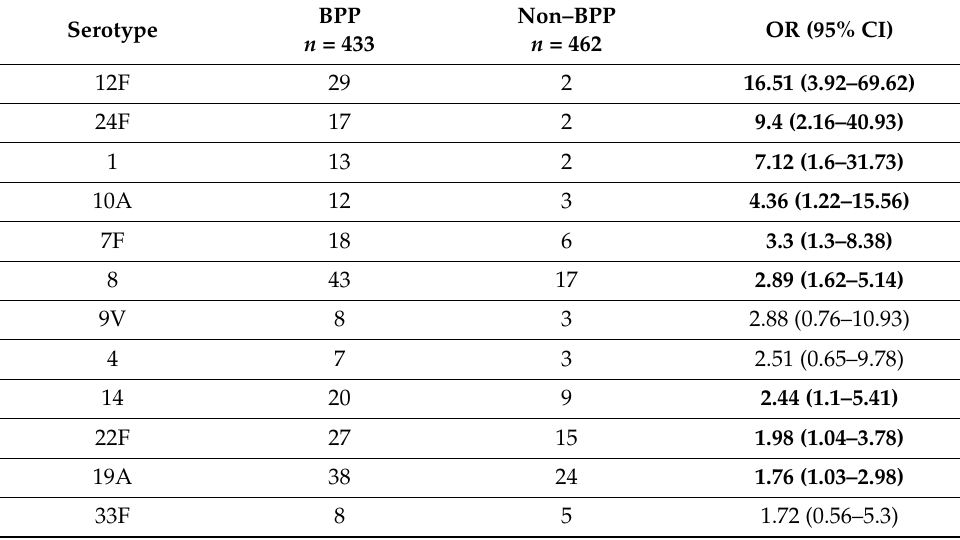
Table A1. Distribution of pneumococcal serotypes causing bacteremic (BPP) and non-bacteremic pneumonia (non-BPP). The serotype-specific odds ratio and 95% CI comparing BPP and non-BPP are shown. Statistically significant results are highlighted in